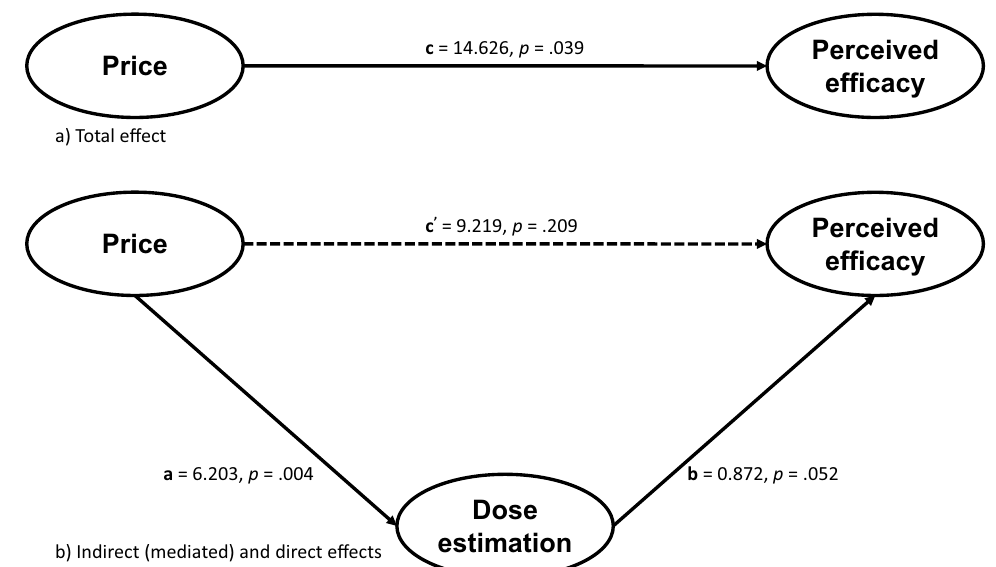
Fig. 4 Structure and estimations of a the direct effect of the price on the perceived efficacy of a drug and b of the effect of the price on the perceived efficacy of a drug mediated by the estimation of administered